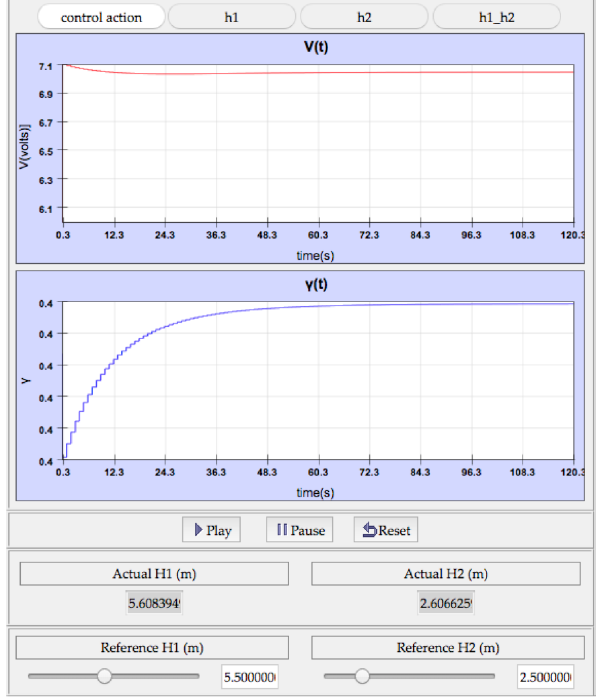
Figure 11. The evolution of the control actions considering the equations of the original (nonlinear)